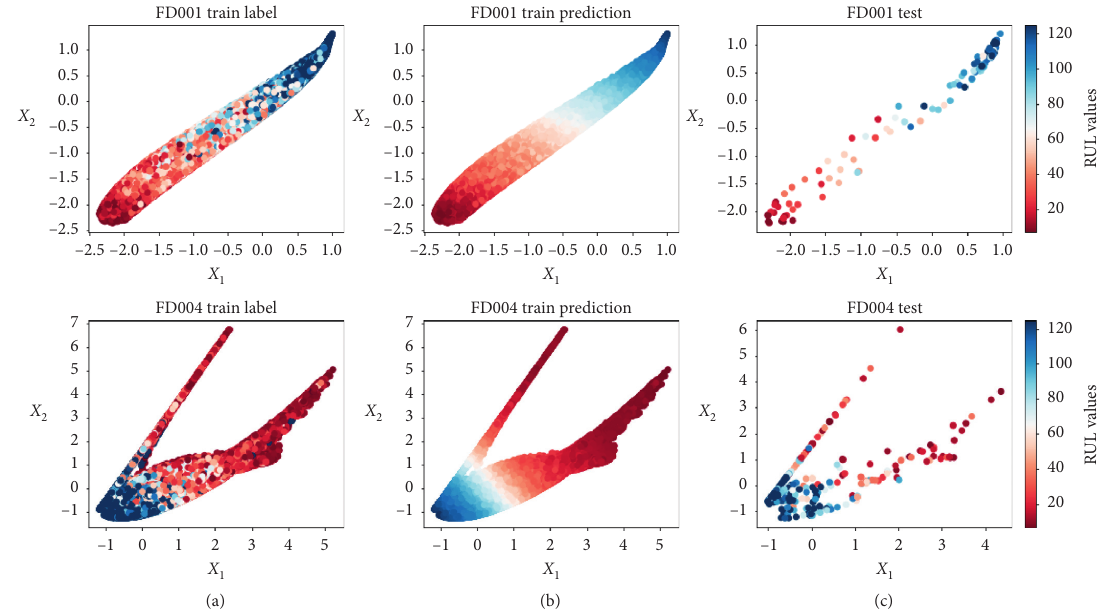
Figure 5: Trained latent variable mapping of RUL training labels (a), RUL training data predictions (b), and RUL testing labels